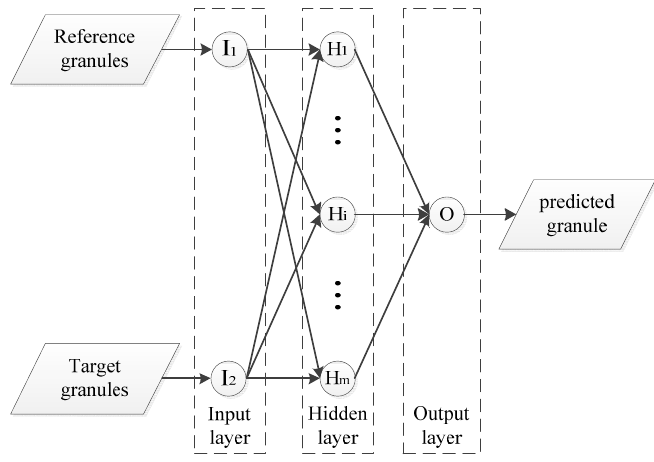
Figure 10. Topological structure of predicted Artificial Neural Network (ANN) in single granular level.